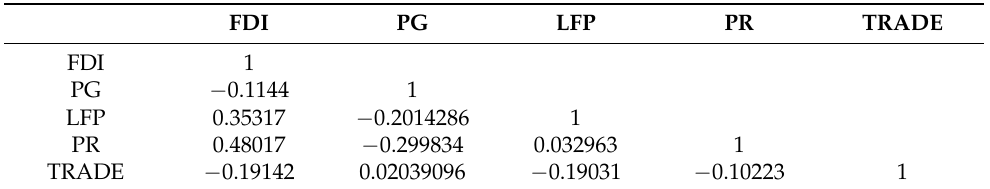
Table 4. Correlation